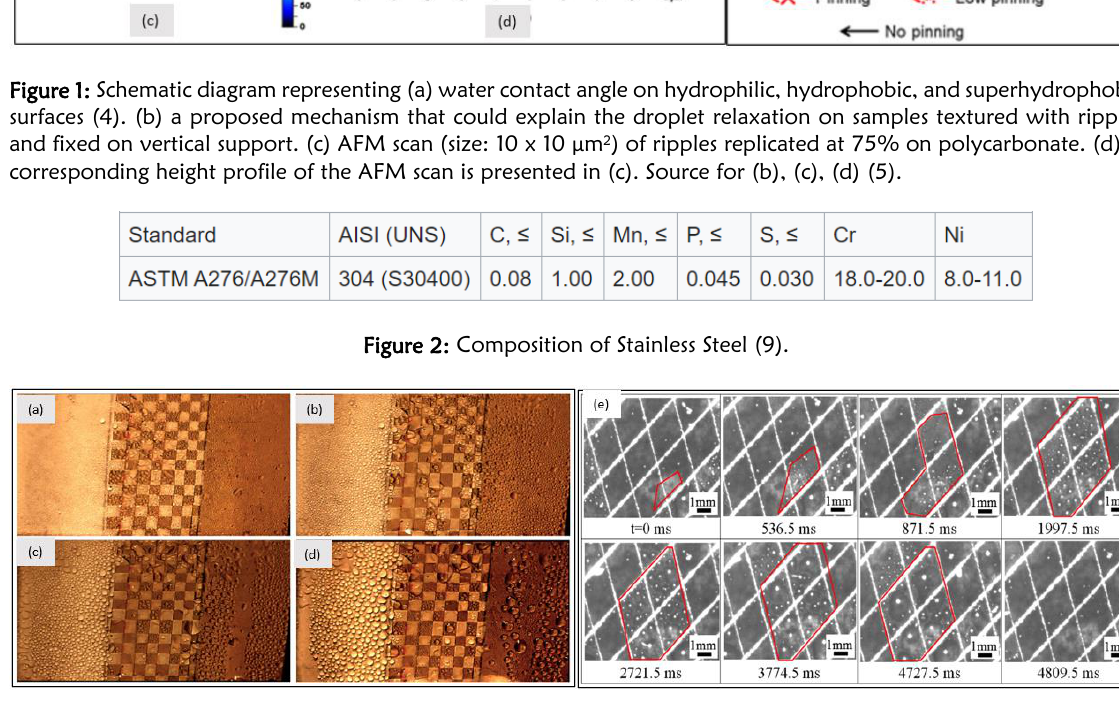
Figure 3: The comparison of the time evolution of condensation process (a-d) on hydrophobic (left), 2mm biphilic (center), and hydrophilic (right) regions. The images are taken every 10 min. The biphilic substrate shows better droplet nucleation and removal throughout the experiment (15). (e) growth, movement, and sweeping of droplets on Hydrophobic SS surface with super hydrophilic